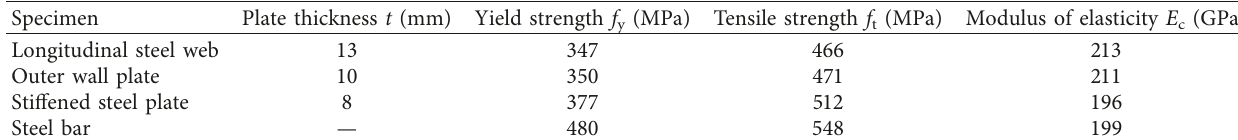
Figure 6: Details of the test specimen (unit: mm). Table 1: Mechanical properties of the steel component.